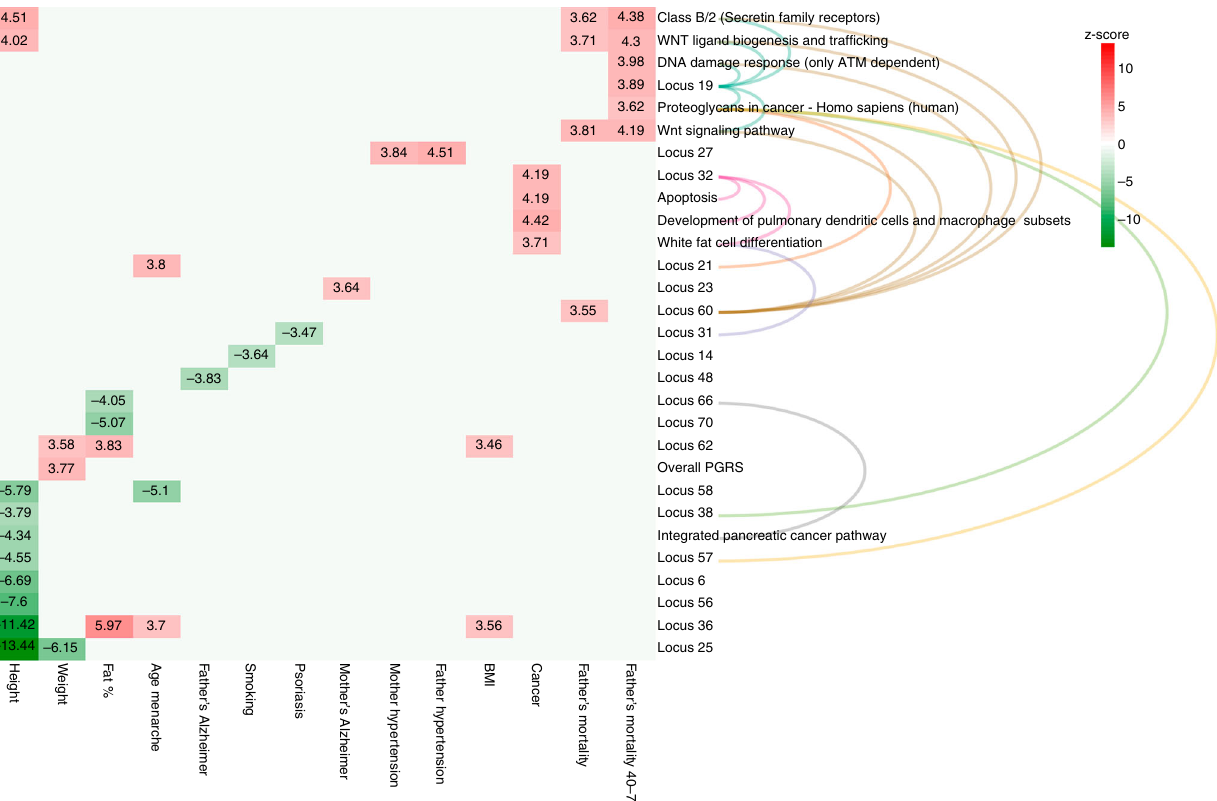
Fig. 3 Signi fi cant effects of individual baldness loci and enriched pathways on disease or mortality risk. Arcs between the loci and the pathways indicate the membership of the genes in that locus in that pathway. The colour and the numbers represent the z-scores from the regressions. Only signi fi cant results ( q value < 0.05) have been reported. Although in several cases, the pathway effects seem to be mainly driven by speci fi c loci, in most cases the overall effect is greater than that of any individual locus. Moreover, we can see examples of pathway-speci fi c effects not attributable to any speci fi c locus, for example, the effect of WNT ligand biogenesis and Class B/2 (Secretin family receptors) pathways on height is detected only at the pathway level and is in the opposite direction to the overall polygenic score and those of the individual